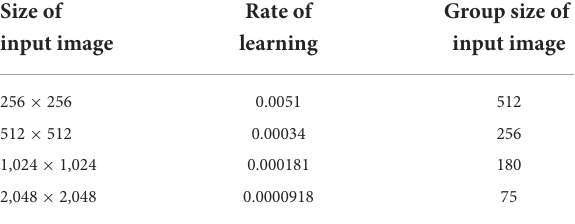
TABLE 3 Classification of learning